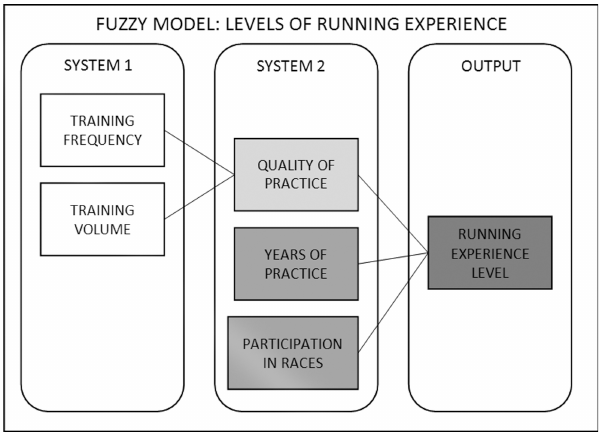
Fig 1. Representation of the fuzzy model with two subsystemsand their respective sets, and the output set of the model.